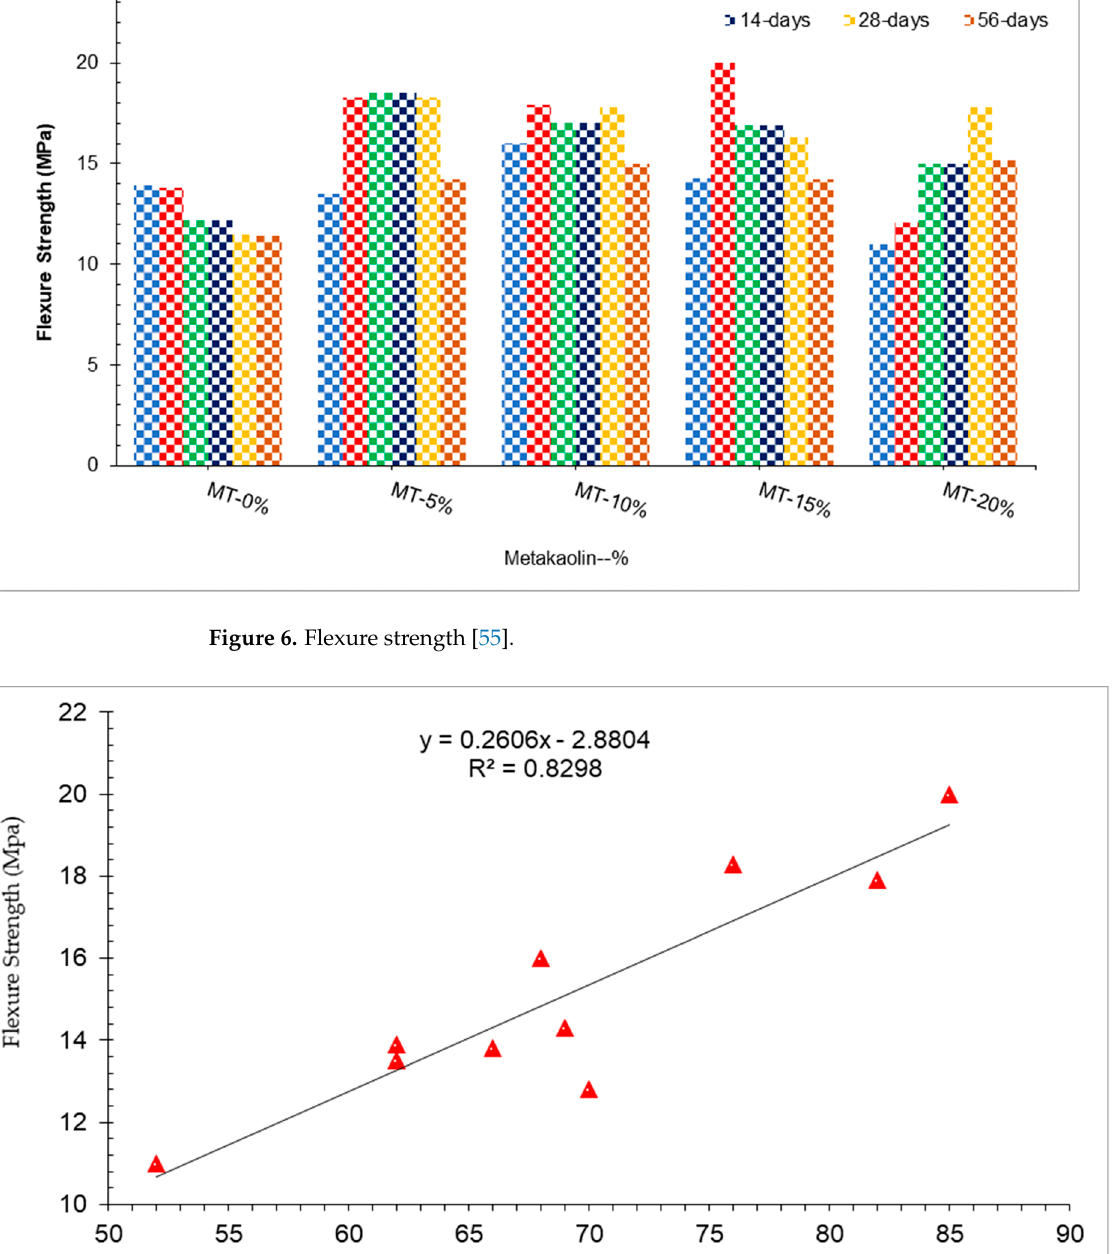
Figure 7. Correlation between compressive and flexure strength: data source [55].